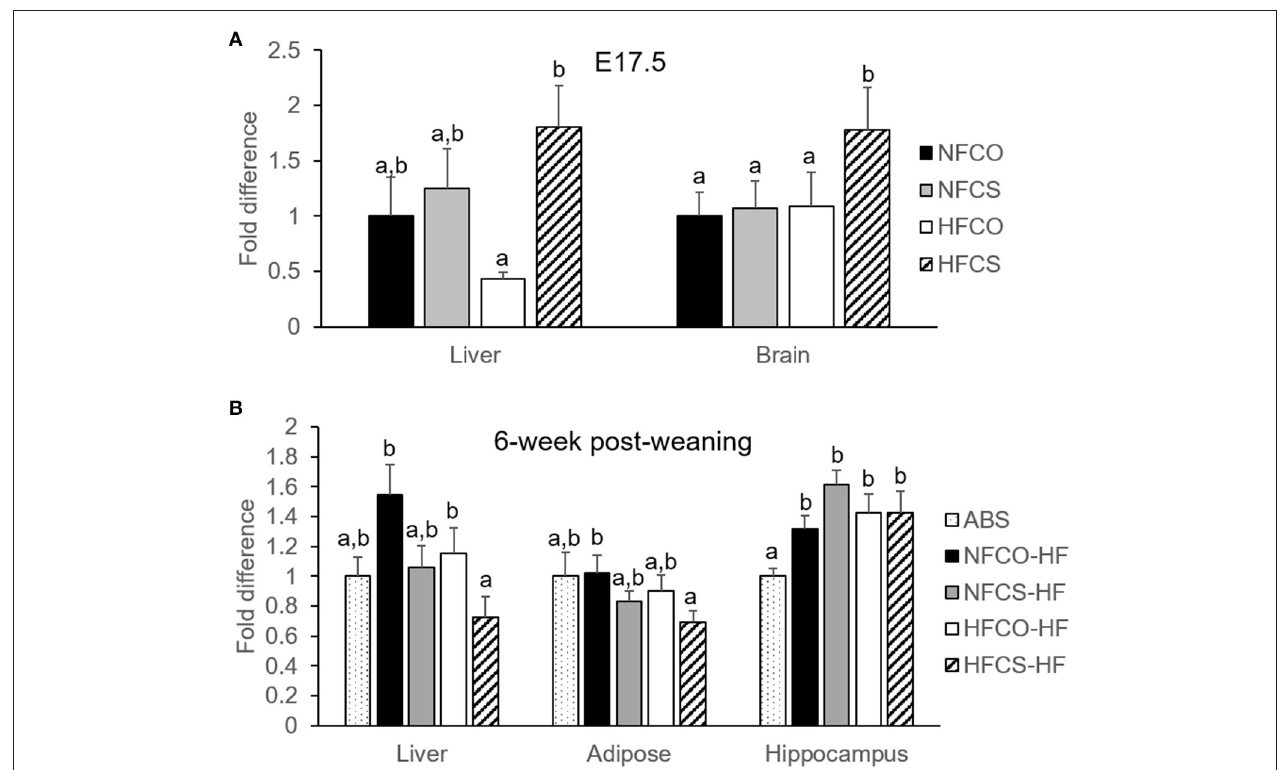
FIGURE 2 | Maternal CS-mediated global DNA hypermethylation was eliminated under postnatal HF feeding. Global DNA methylation of mouse offspring with different maternal diets at E17.5 (A) and after 6-week post-weaning high-fat feeding (B) . Different letters (e.g., a, b) represent statistically significant difference, p < 0.05. n = 6–8 per sex per group. ABS, absolute control; CO, control without choline supplement; CS, choline supplemented; HF, high-fat; NF, normal-fat.